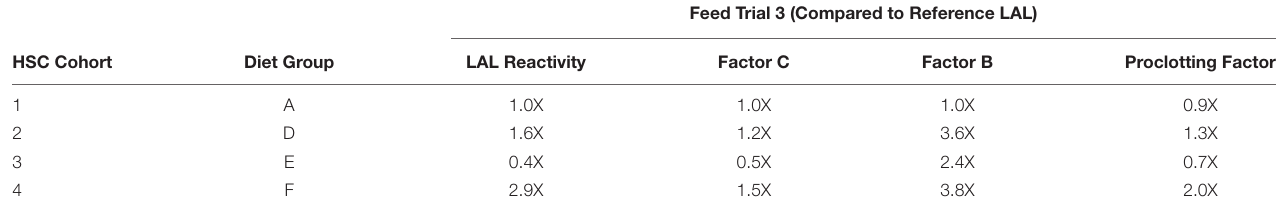
TABLE 5 | Effect of diet on aquaculture LAL reactivity and protein expression vs. reference